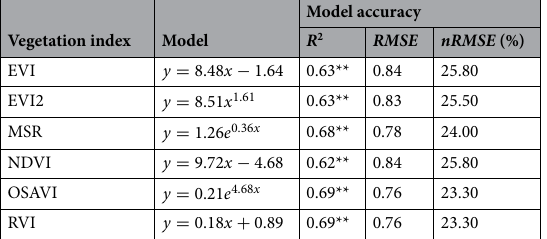
Table 2. LAI inversion model and accuracy using Sentinel-2 remote sensing data. **Indicates the significance level of